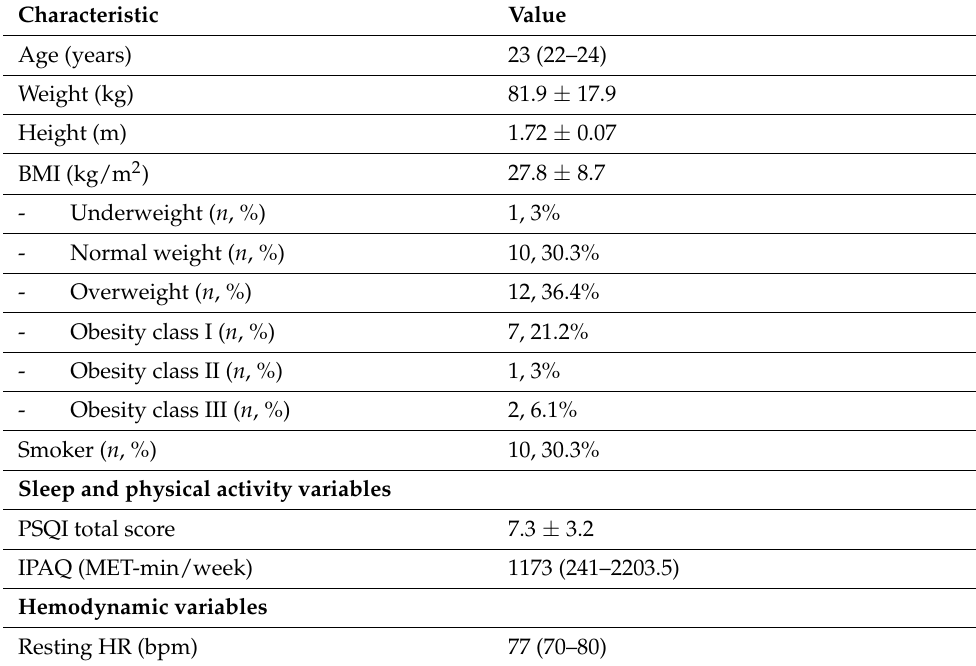
Table 1. Demographic characteristics of the